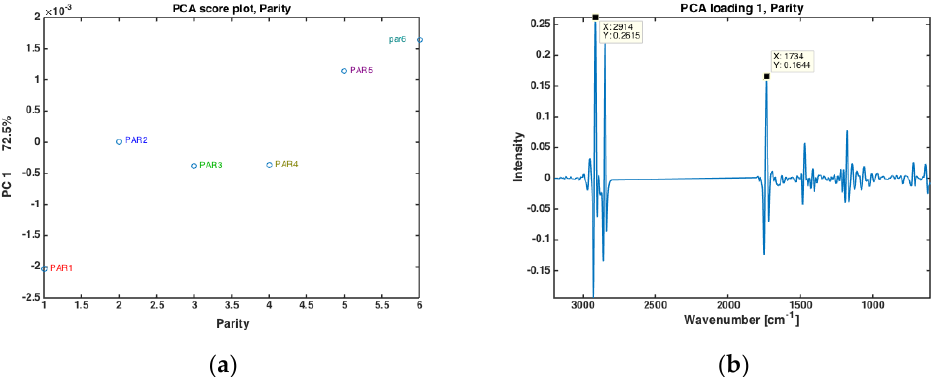
Figure 2. PCA of all FTIR spectra of milk samples for different parity groups (PAR1 = first-parity cows, PAR2 = second parity cows, PAR3 = third-parity cows, PAR4 = fourth-parity cows, PAR5 = fifth-parity cows, PAR6 = sixth-parity cows) ( a ) Score plot, and ( b ) loading plot of PC 1.